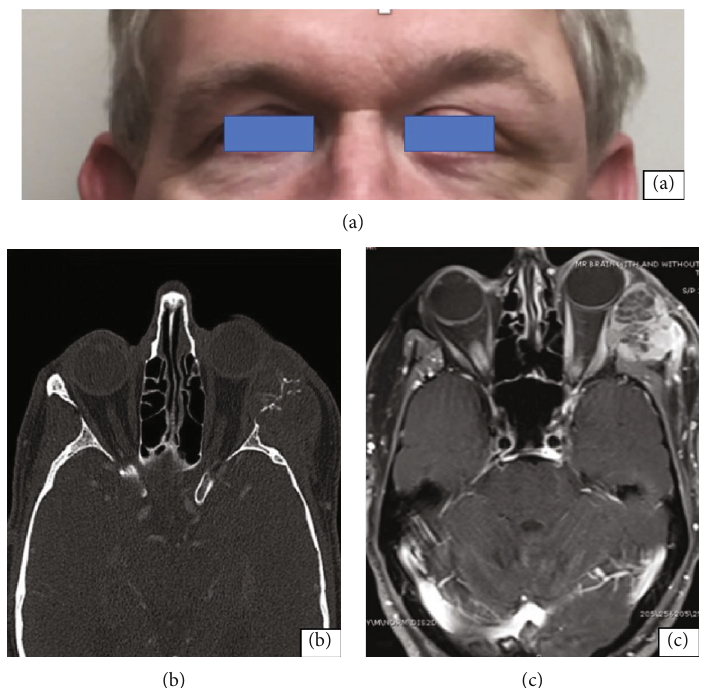
Figure 1: (a) Clinical photo of the patient at time of presentation, direct view. (b) Computed tomography maxillofacial, axial cut. Illustrating a 3.8cm mass of the lateral orbit eroding the lateral orbital wall with a soft tissue component extending into the orbit causing proptosis and nonaxial displacement of the globe. (c) MRI brain and orbit T1 fat-suppressed image with gadolinium showing a lobulated mass with mixed cystic and solid components and inhomogeneous enhancement, involving the left lateral orbital wall and suprazygomatic left masticator space. Additionally, the mass demonstrates edema and enhancement suggesting in fi ltration by the